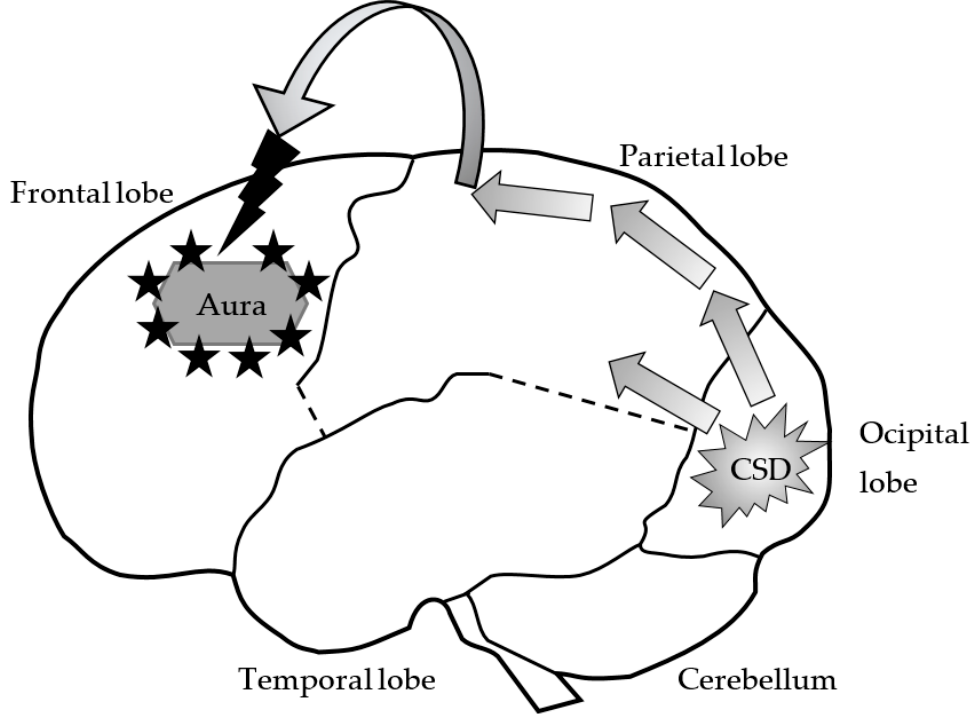
Figure 1. Cortical spreading depression. Changes in central nervous system flow that may induce a migraine attack may be associated with the occurrence of spreading cortical spreading depression (CSD). Oligemia (reduced vascular flow) begins in the occipital and parieto-occipital areas, then moves through the cerebral cortex and stops at the medial and lateral sulcus. In some patients, CSD may extend to the frontal lobes. This phenomenon seems to be responsible for the aura formation during a migraine headache.